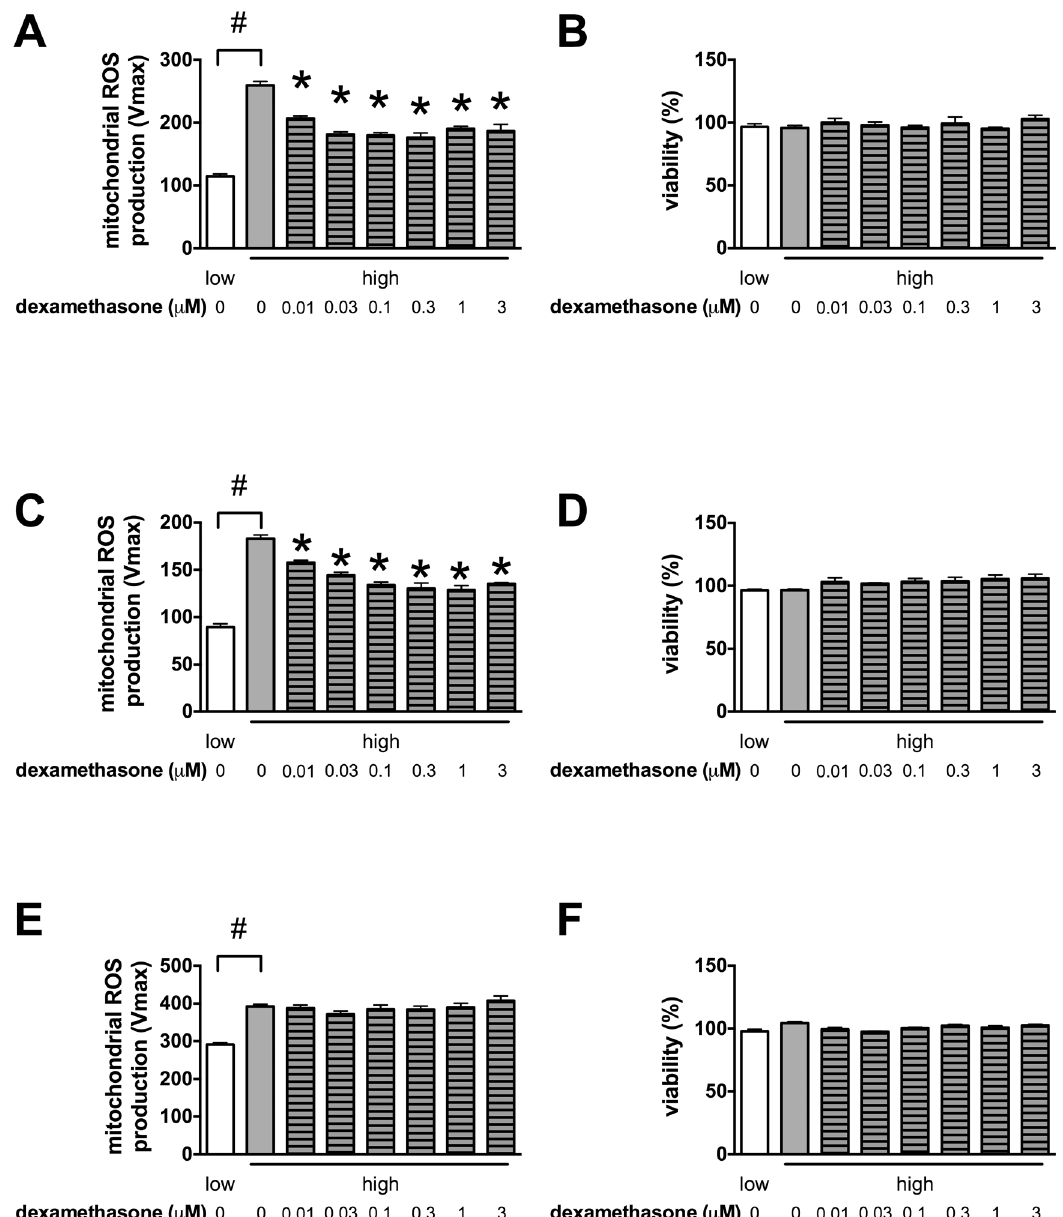
Fig 2. Glucocorticoids decrease the glucose-induced mitochondrial ROS production in microvascular endothelial cells. A, B: b.End3 microvascular endothelial cells were exposed to high glucose for 7 days and were treated with dexamethasone at the indicated concentrations for 3 days. A: ROS production was measured with the mitochondrial superoxide specific MitoSOX Red and (B) the viability was determined by measuring the Hoechst 33342 DNA dye uptake. C, D: b.End3 cells were exposed to high glucose for 7 days and were treated with mifepristone at the indicated concentrations for 3 days. C: ROS production was measured with the mitochondrial superoxide specific MitoSOX Red and (D) viability was determined by measuring the Hoechst 33342 DNA dye uptake. E, F : EA.hy926 human venous endothelial cells were exposed to high glucose for 7 days and treated with dexamethasone at the indicated concentrations for 3 days. E : The mitochondrial superoxide production was determined by MitoSOX Red stain and F : the viability by Hoechst 33342 DNA dye uptake. (#p < 0.05 high-glucose exposure induced significant changes compared to cells maintained in low glucose containing medium, * p < 0.05 glucocorticoid treatment significantly reduced the ROS production.)